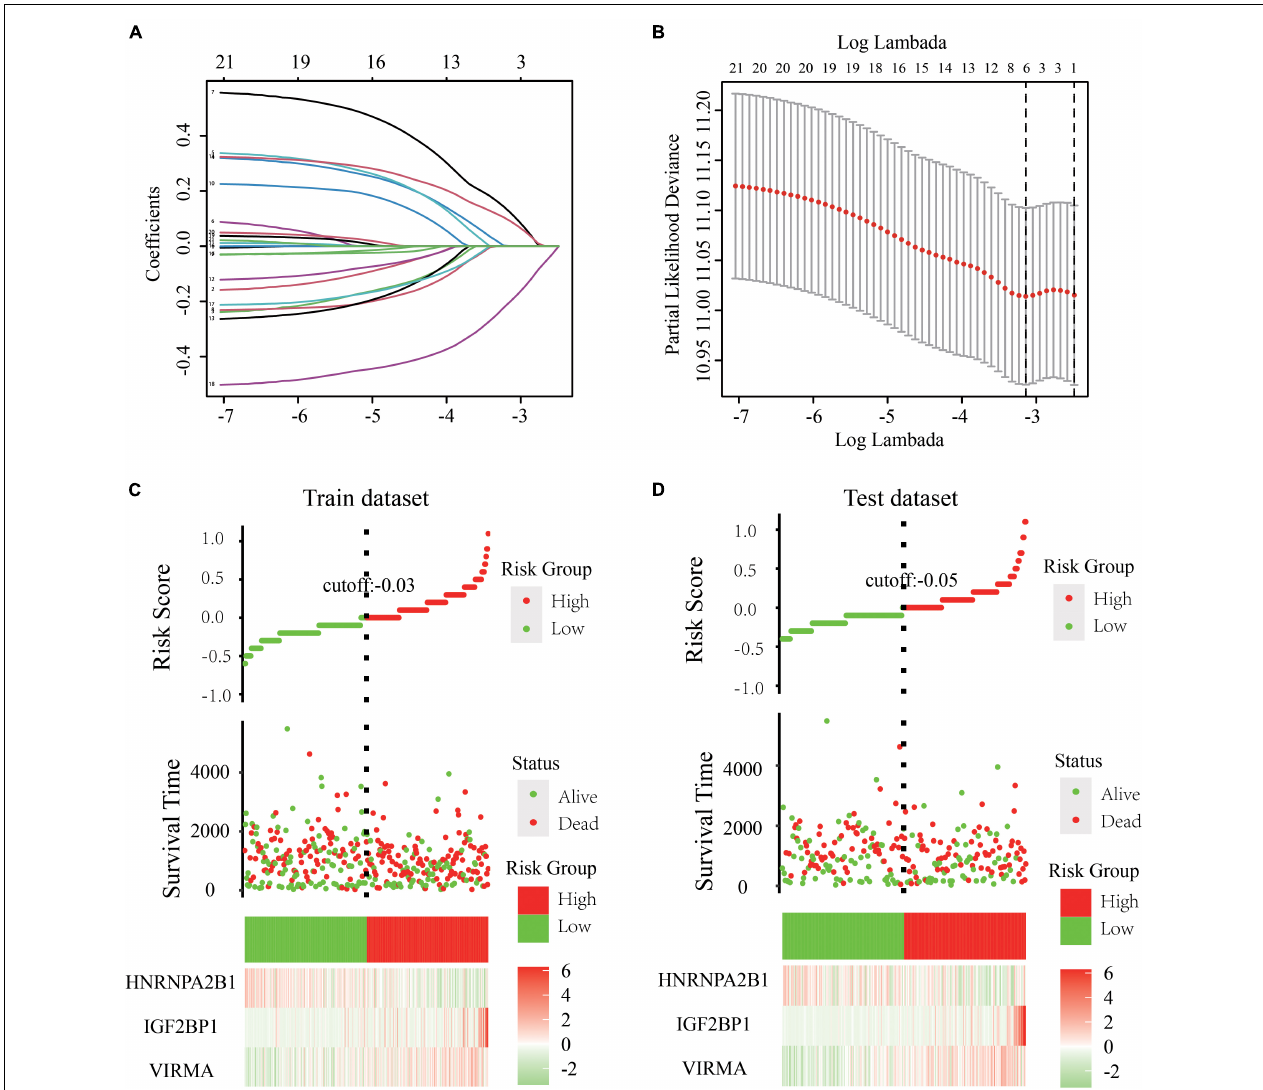
FIGURE 3 | Development of a risk signature consisting of three m6A RNA methylation regulators to predict the prognosis of patients with OC. (A,B) LASSO Cox regression algorithm for the 21 regulators in the GDC dataset and obtained risk scores based on three m6A regulators (VIRMA, IGF2BP1, and HNRNPA2B1) as variables. (C) Using the median risk score (–0.03) as the cutoff point, all the 361 patients in the train dataset were divided into two groups, namely, the high-risk group and the low-risk group. (D) Using the median risk score (–0.05) as the cutoff point, 252 patients in the test dataset were also divided into two groups as previously described. A KM survival analysis was subsequently performed to evaluate the effectiveness of the three selected m6A regulators and to construct a risk model for the survival rate of patients with OC both in the train and test